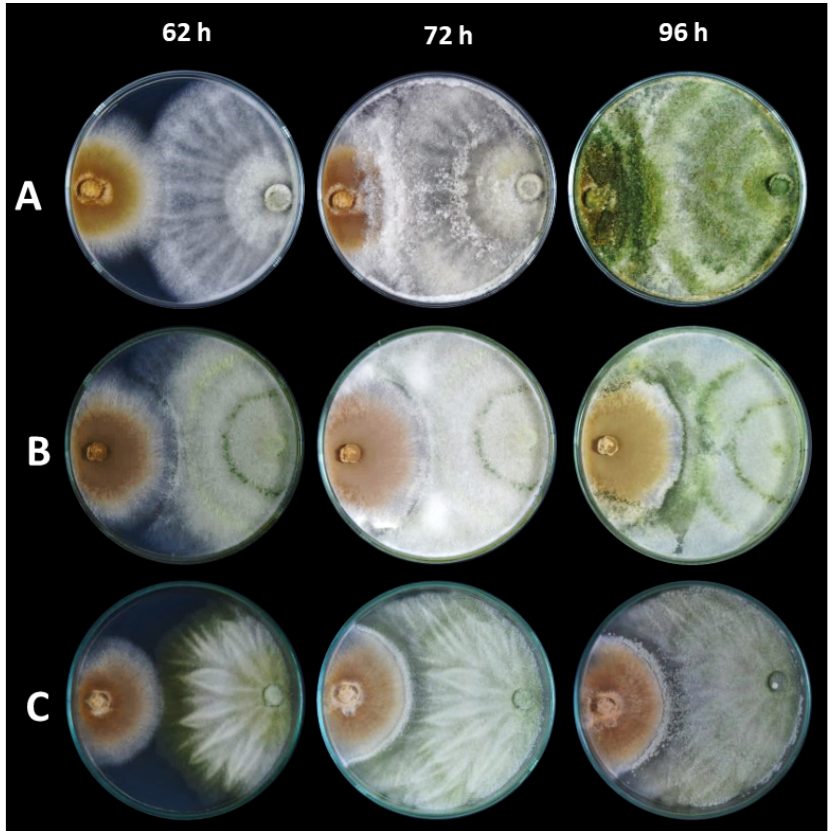
Figure 2. Antibiosis test against Moniliophthora roreri . ( A ) Example of a test with high antibiosis level ( Trichoderma afroharzianum strain F13M4 in a dual culture with M. roreri at 62, 72, and 96 h of confrontation). ( B ) Example of a test with medium antibiosis level ( T. reesei strain UCF7_M2 in a dual culture with M. roreri at 62, 72, and 96 h of confrontation). ( C ) Example of a test with low antibiosis level ( T. afroharzianum strain F12M3 in a dual culture with M. roreri at 62, 72, and 96 h of